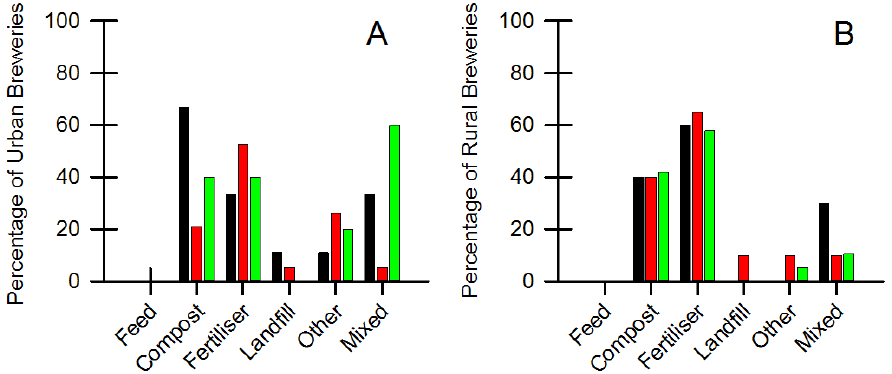
Figure 5. Spent hops disposal method in urban and rural based craft breweries. ( A ) Urban-based craft brewers; ( B ) rural-based craft breweries. Black bars: breweries with a batch capacity smaller than 1000 L; Red bars: breweries with a batch capacity greater than 1000 L, but smaller than 2000 L; Green bars: breweries with a batch capacity greater than 2000 L. Total figures might add up to over 100% because some breweries employ multiple methods of